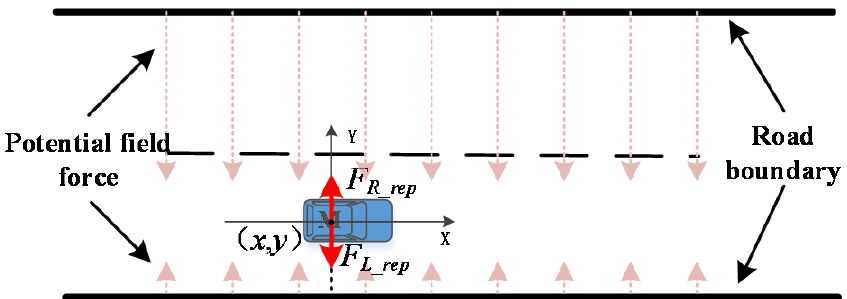
Figure 3. Schematic diagram of the road boundary repulsive potential field force.